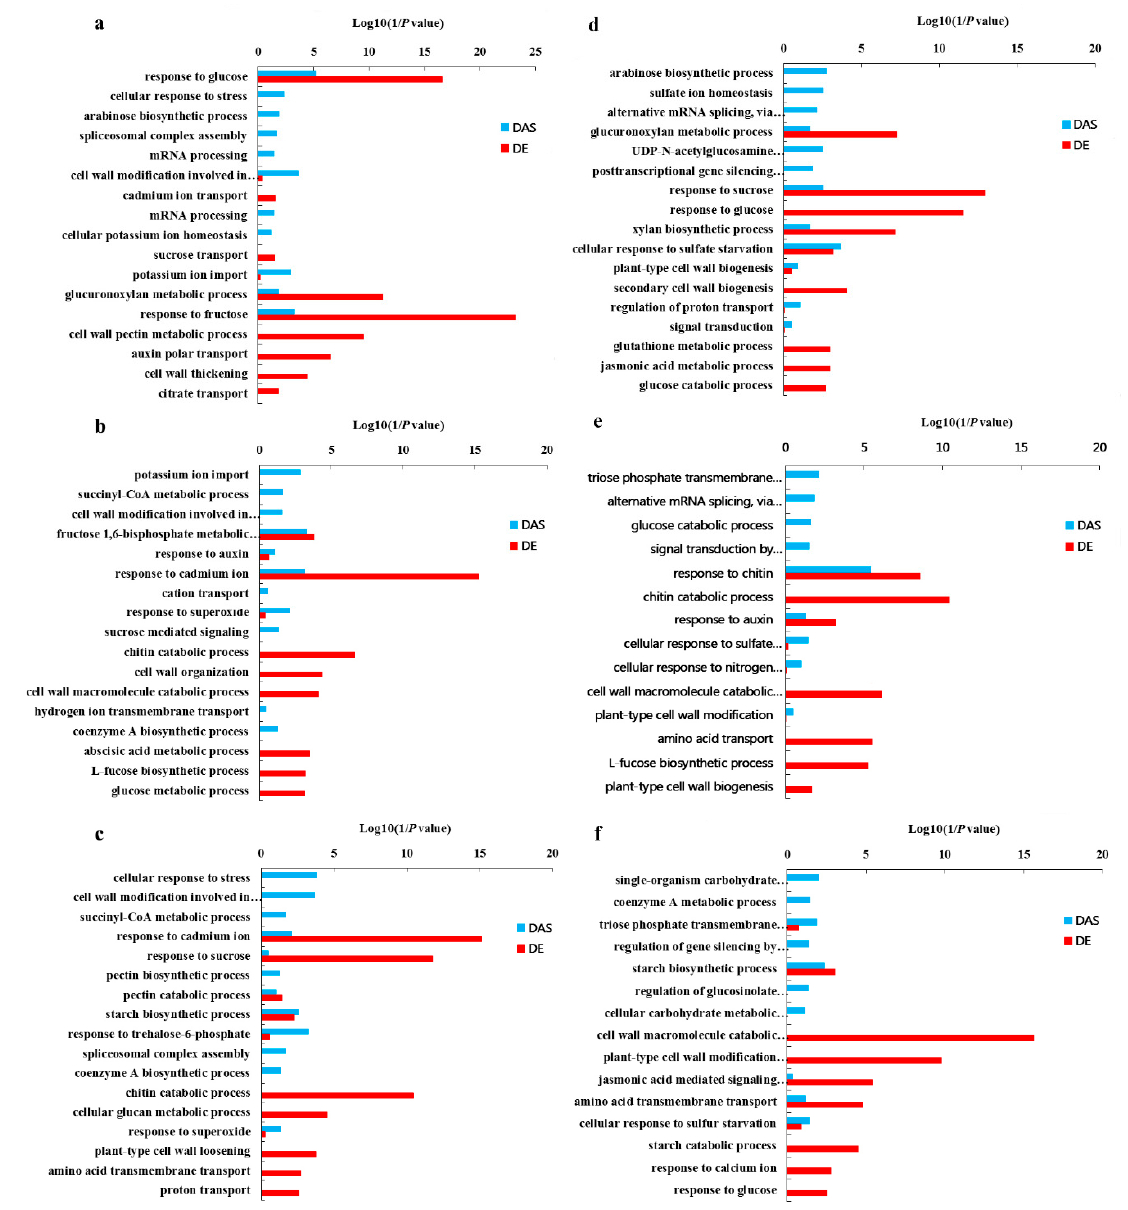
Figure 11. GO terms of the functional categorization of DAS and DE genes (biological process) in the root, juvenile leaves and old leaves of B. napus cultivars Qingyou10 (QY10) and Westar10 (W10) under B deficient conditions: ( a ) root of QY10; ( b ) juvenile leaves of QY10; ( c ) old leaves of QY10; ( d ) root of W10; ( e ) juvenile leaves of W10; and ( f ) old leaves of W10.